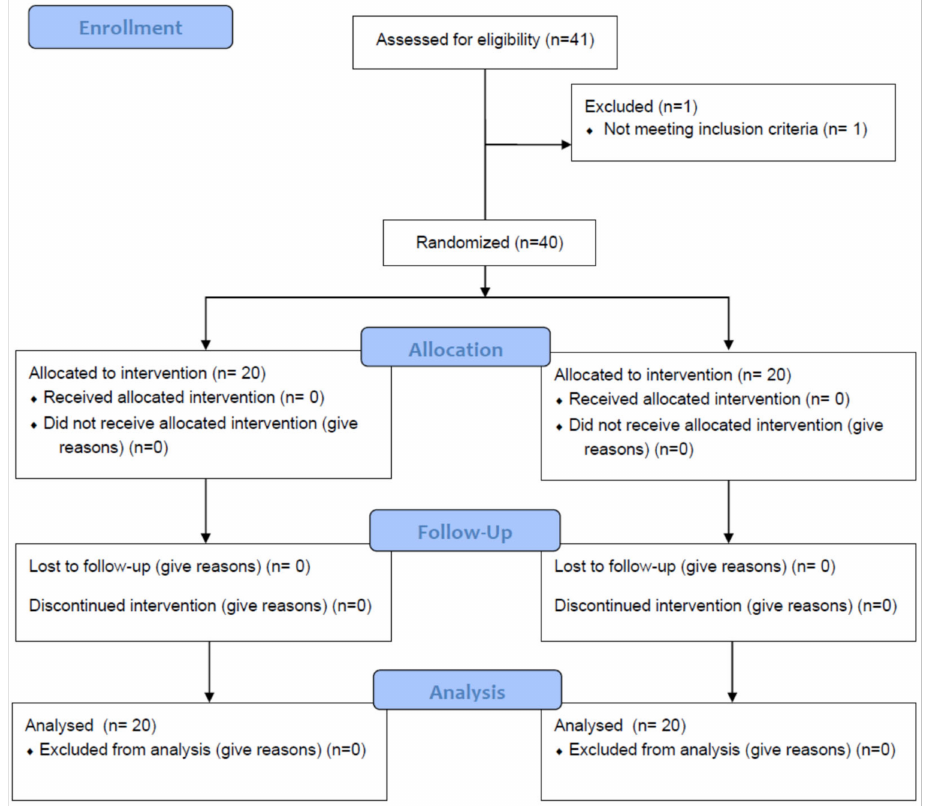
Figure 1. CONSORT statement flow diagram. Abbreviations: BMI, body mass